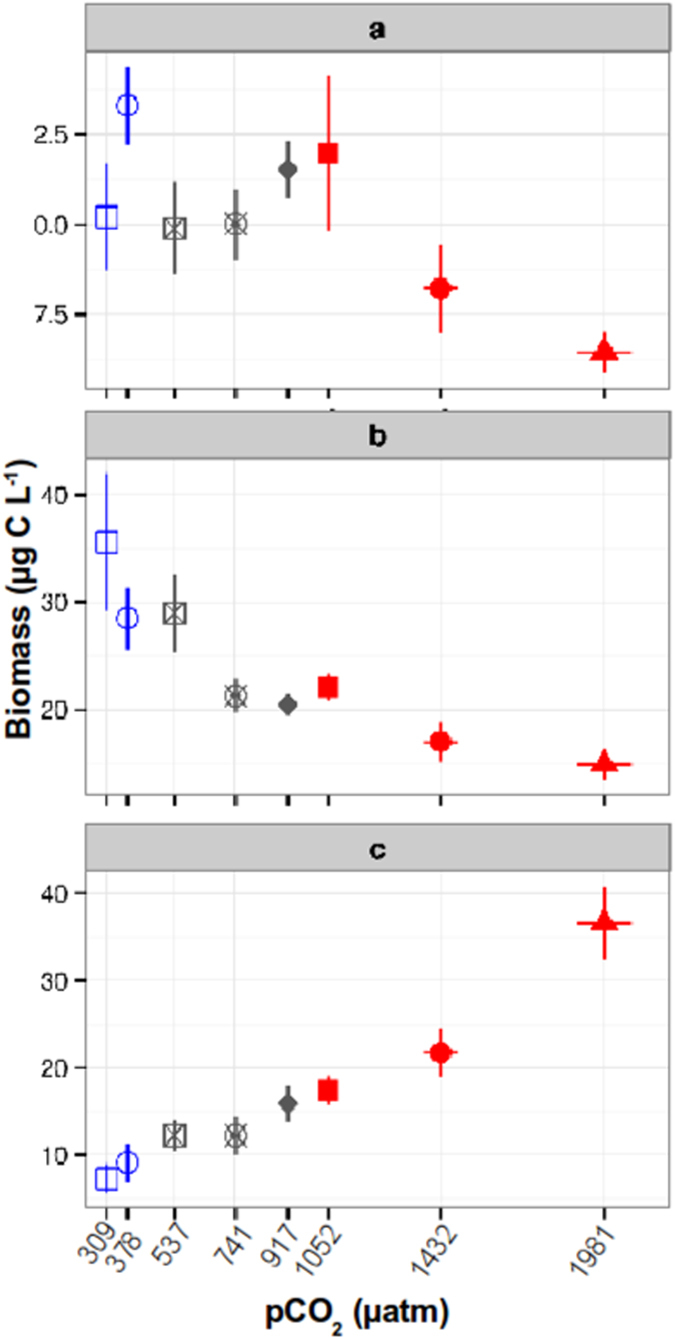
Average calculated biomass of the phytoplankton between sampling days 3 and 25, by size fraction: (a) microplankton (>10 μm), (b) nanoplankton (10–2.7 μm) and (c) picoplankton (<2.7 μm) in the CO2 gradient treatments during the experiment. A Mixed Effect Model analysis showed that all size fractions had significant differences in biomass between the pCO2 treatments. The x-axes display the mean CO2 levels (μatm) during the analyzed time period in each mesocosm, bars show standard error.